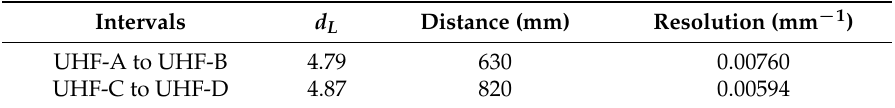
Table 3. d HS values of the intervals across the